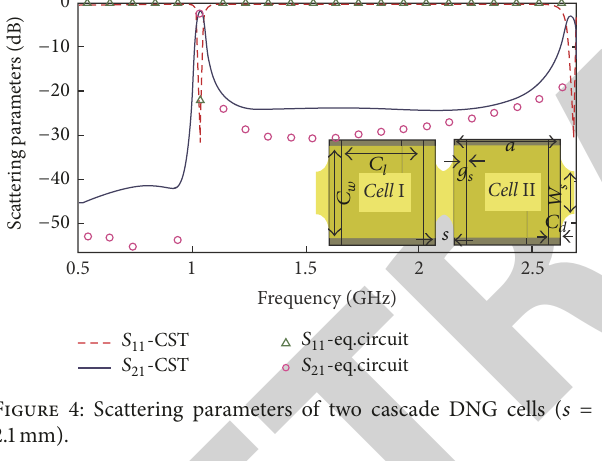
Figure 4: Scattering parameters of two cascade DNG cells ( 𝑠 = 2.1 mm).